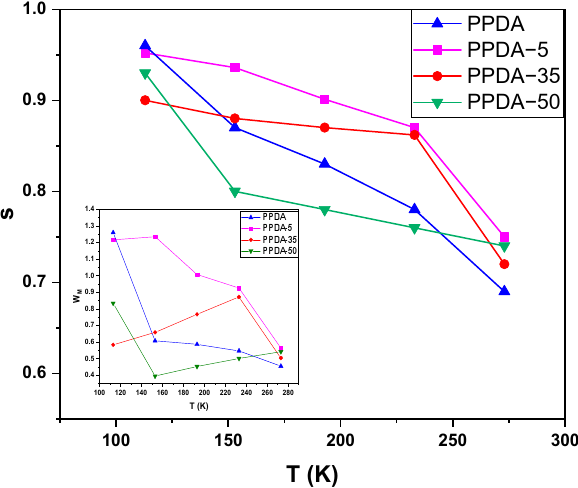
Figure 13. Variation in exponent parameter s with temperature for PPDA and PPDA/MMT composites. The solid lines are drawn for clarity. Inset shows the variation in W M with temperature.